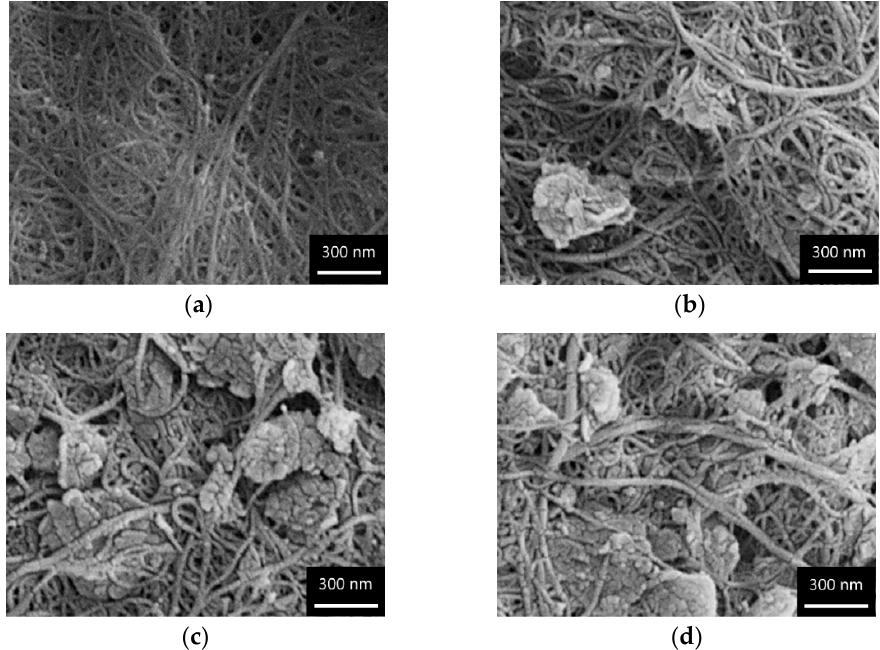
Figure 2. SEM images of ( a ) SWCNT BP, ( b ) 25% GO-SWCNT BP, ( c ) 50% GO-SWCNT BP, and ( d ) 75% GO-SWCNT BP, showing the presence of GO flakes homogeneously embedded in the SWCNT BP network.